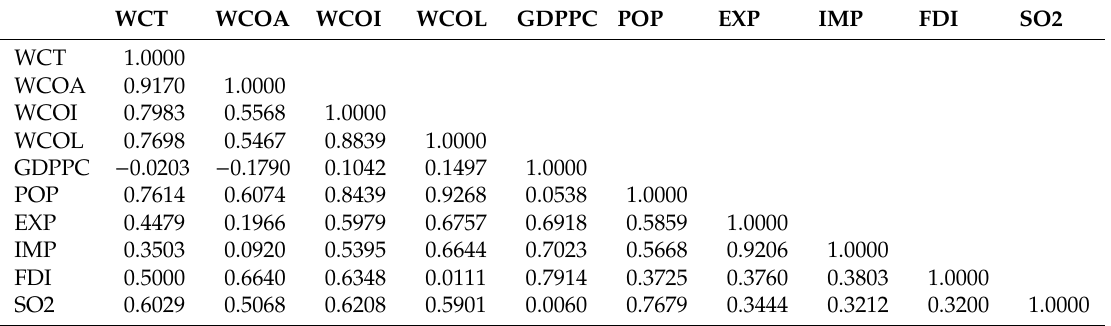
Table 3. The correlation matrix (whole of